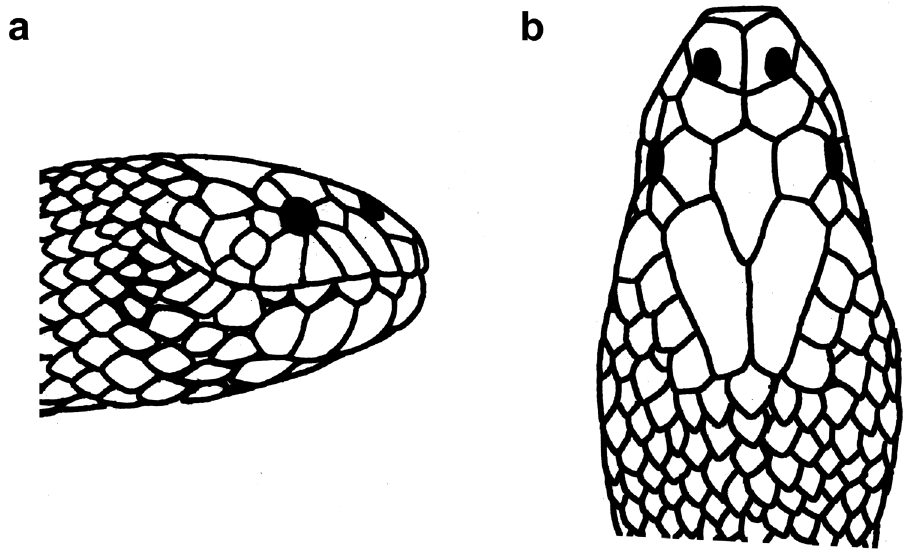
Figure 21. Head of Hydrophis lapemoides : a lateral view b dorsal view.